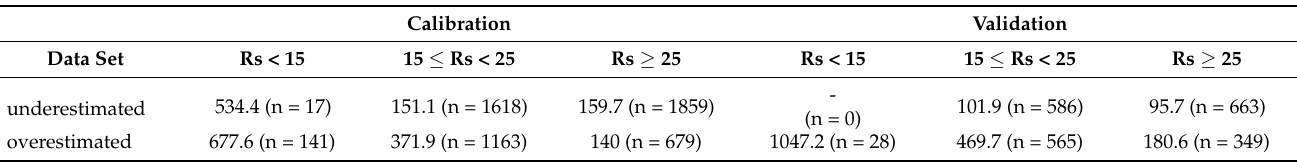
Table 14. RMSE values (J · cm − 2 · day − 1 ) and number of data points belonging to under- and overestimation sets in three defined intervals of measured solar radiation (MJ · m − 2 · day − 1 ) for calibration and validation phases using proposed